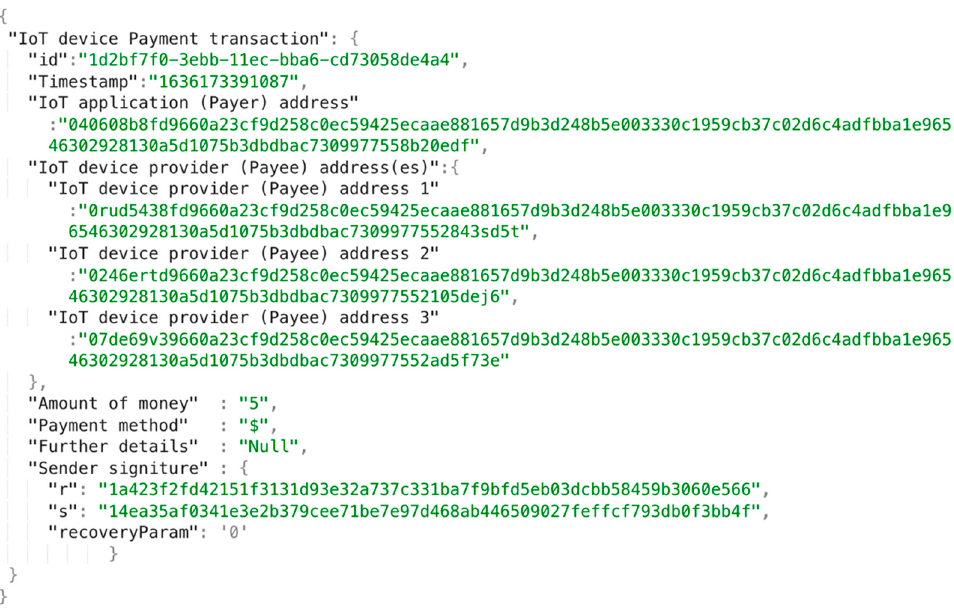
Figure 4. IoT device payment transaction with paying three IoT devices example.